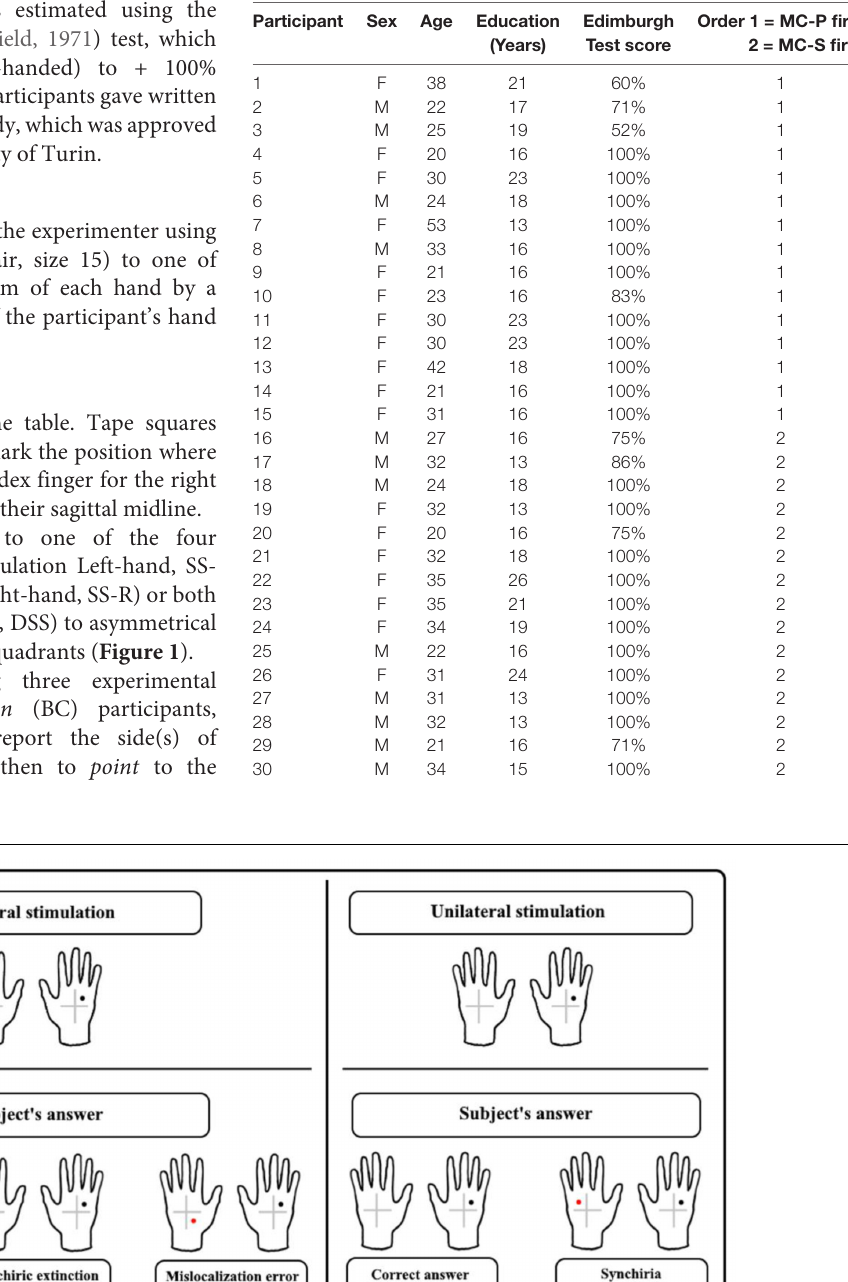
TABLE 1 | Participants’ demographic and experimental data.